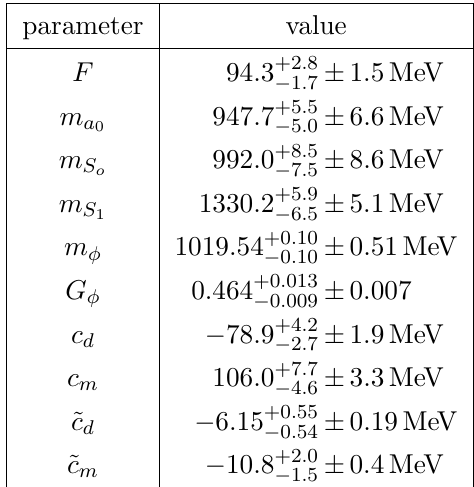
Table 3 . Results of the D + ! K (cid:0) K + K + Dalitz plot (cid:12)t with the Triple-M amplitude.